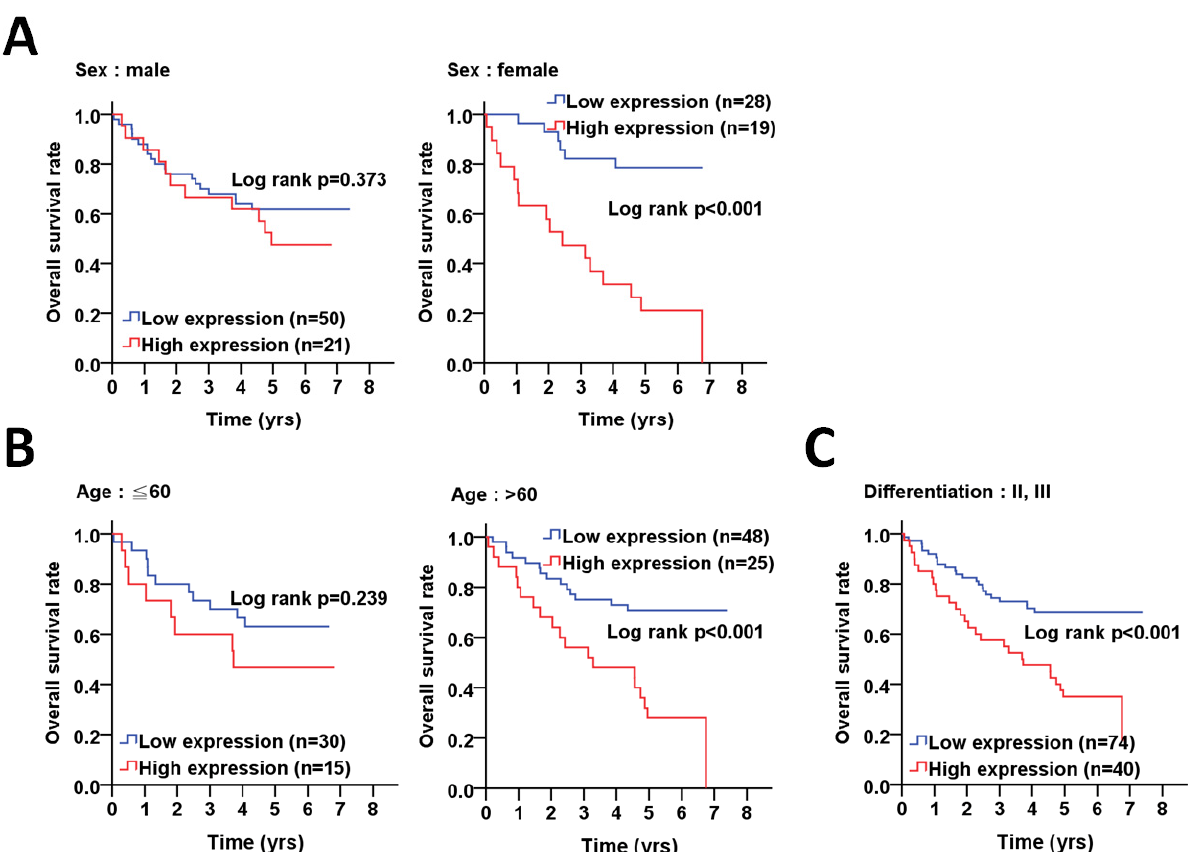
Figure 2. The clinical relevance of ATG5 protein levels on sex, age and differentiation with overall survival in colorectal cancer patients. ( A ) Kaplan–Meier plots were used for the stratified analysis to determine the association of ATG5 protein level with the overall survival based on sex, ( B ) age (60 years old) and ( C ) differentiation. The cutoff values for the high or low ATG5 protein levels in tumor tissues were selected according to the ROC curve. The significance of ATG5 protein levels on survival is shown with log rank.